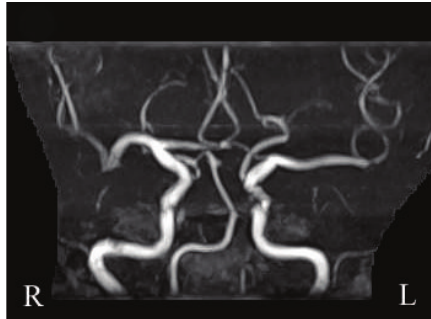
Figure 3: MRA revealed less visibility and stenotic changes of right middle cerebral arteries.